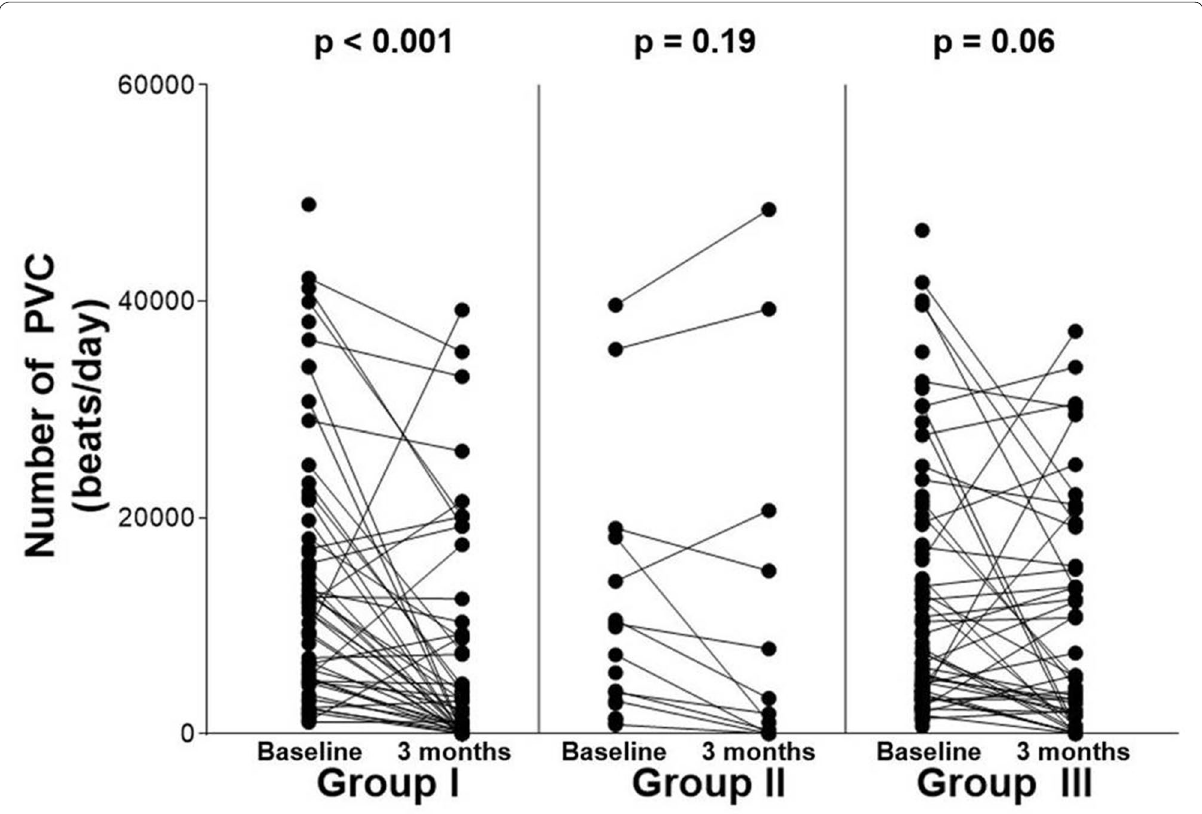
Fig. 2 Changes in the number of PVCs after β‑blocker treatment according to groups. The density of the PVC was significantly reduced only in patients of Group I, and there were no significant differences in those of Group II and Group III. PVC